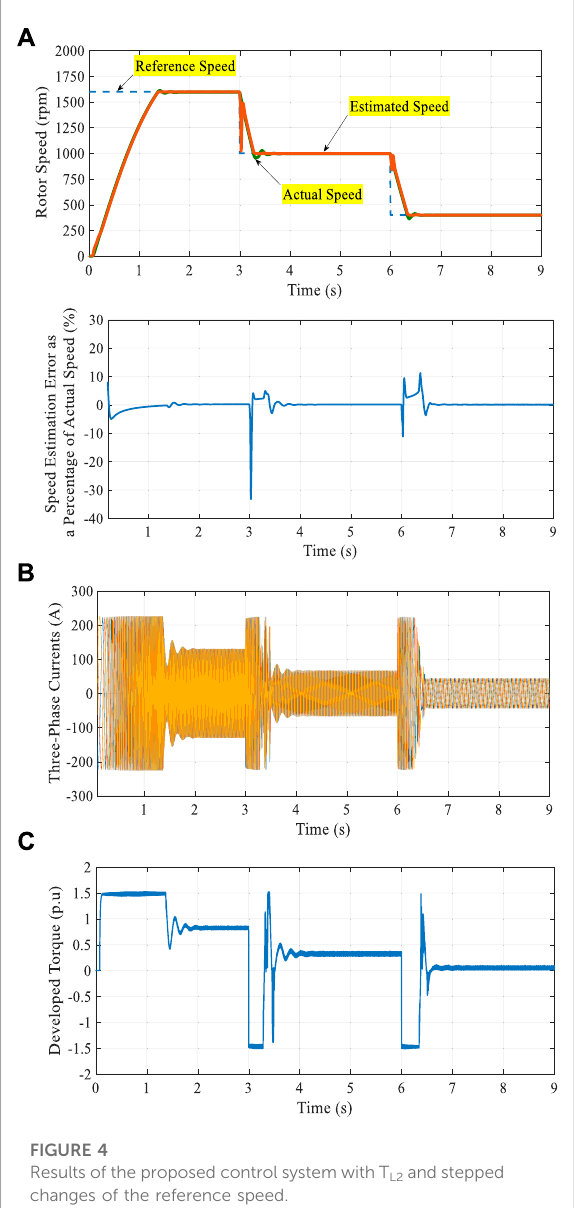
FIGURE 4 Results of the proposed control system with T L2 and stepped changes of the reference